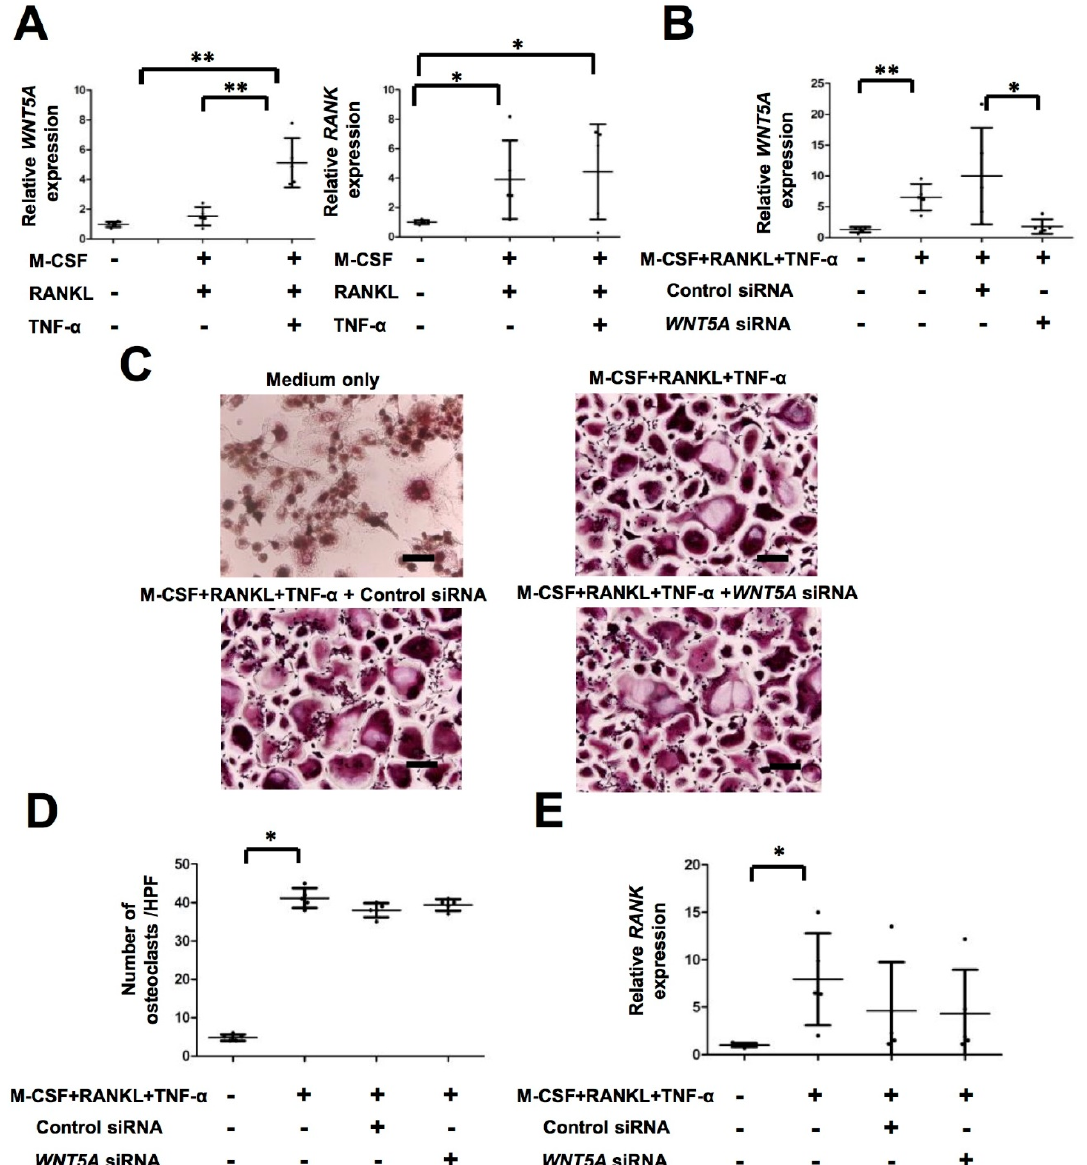
Figure 2. Osteoclastogenesis and RANK expression in MDOC is independent of WNT5A expres- sion. ( A ) The expression of WNT5A and RANK in CD14 + monocytes after M-CSF and RANKL with/without TNF- α treatment on Day 13 was measured using qRT-PCR ( n = 5). ( B ) MDOC were transfected with either control siRNA (100 µ g/mL) or WNT5A siRNA (100 µ g/mL) to investigate the dynamic expression level of WNT5A during MDOC differentiation using qRT-PCR. ( C ) MDOC trans- fected with control siRNA or WNT5A siRNA were identified morphologically using TRAP staining. The numbers of MDOC were determined ( D ) by averaging the TRAP+ cells in four high-power fields ( n = 5). Scale bar: 50 µ m. ( E ) The relative expression of RANK in MDOC transfected with control siRNA or WNT5A siRNA was measured using qRT-PCR. The error bar is the standard deviation of each data set. * p indicates p < 0.05 and ** indicates p <